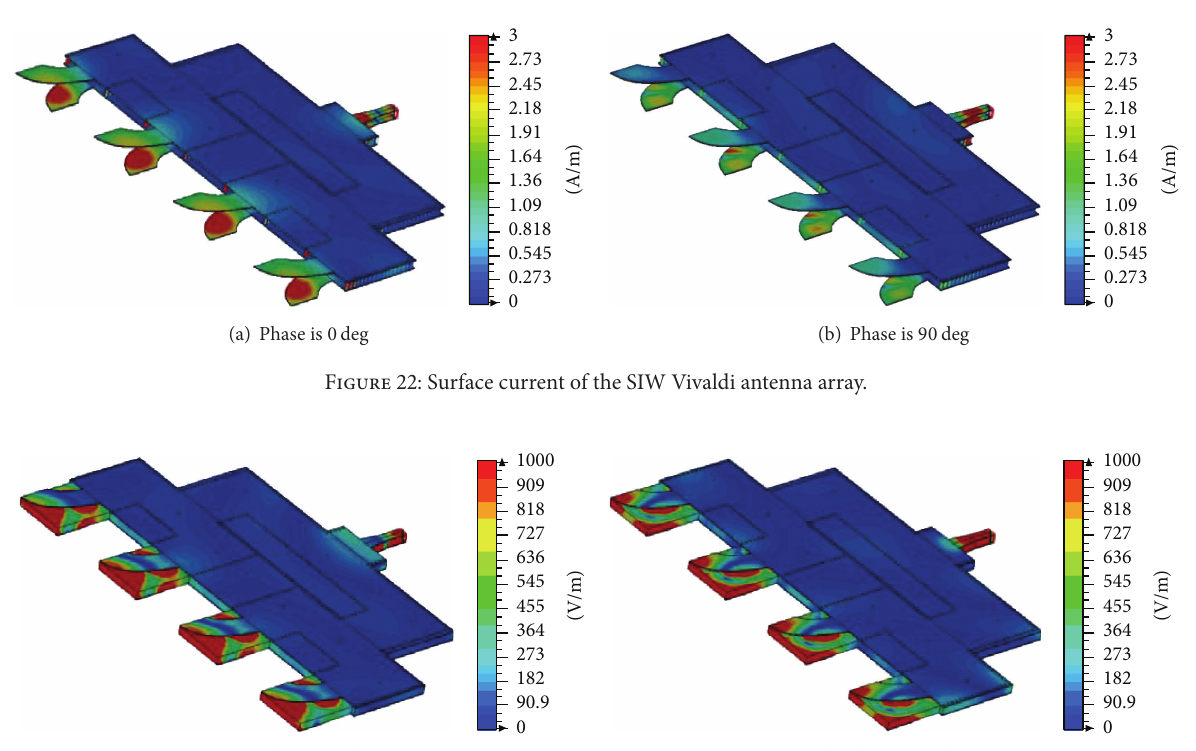
Figure 24. The array gain can reach 14 dB on 9.5 GHz in simulation, and the main lobe width is about 17.3 measured gain is about 13.3 dB, and the main lobe width is about 16.9 ∘